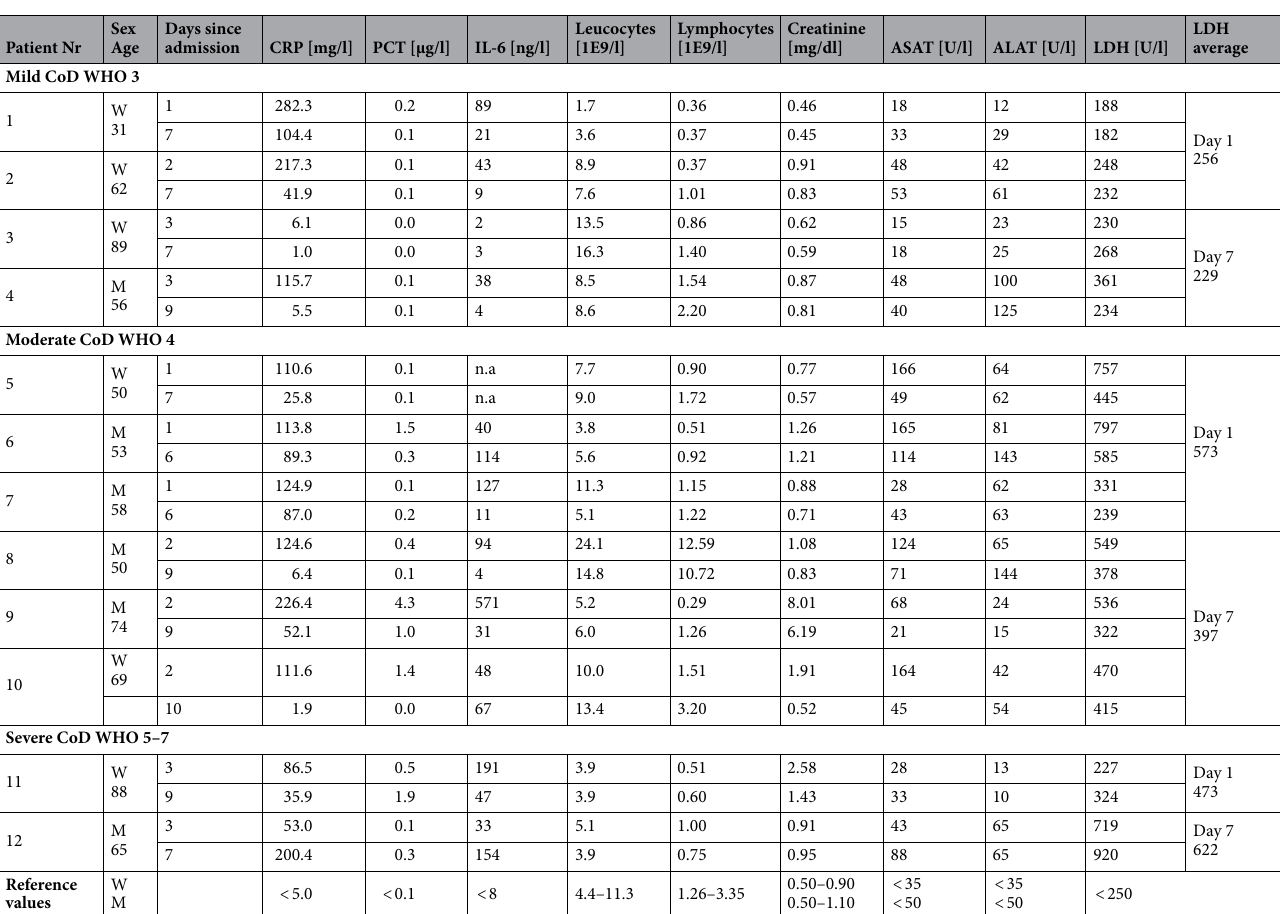
Table 1. Clinical parameters of the patients. CoD = course of the disease. The age of the patients is reported in years.